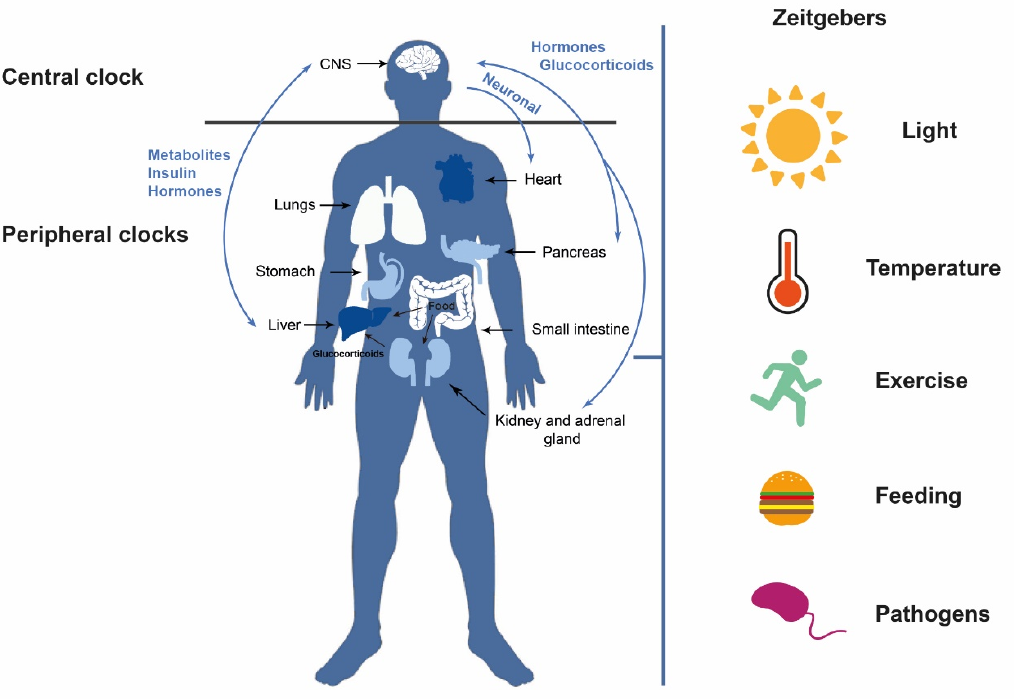
Figure 1. Circadian clocks. The central clock, primarily stimulated by light, communicates with the peripheral clocks and vice versa, through neurotransmitters, neuropeptides, and hormonal secre- tions. Other external zeitgebers can also influence circadian rhythms such as temperature, feeding, exercise, and pathogens, among